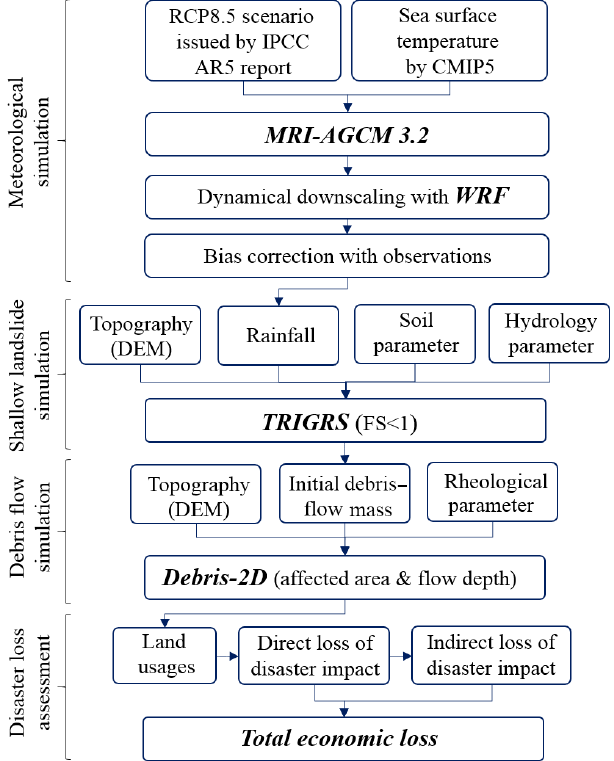
Figure 1. Integrated simulation